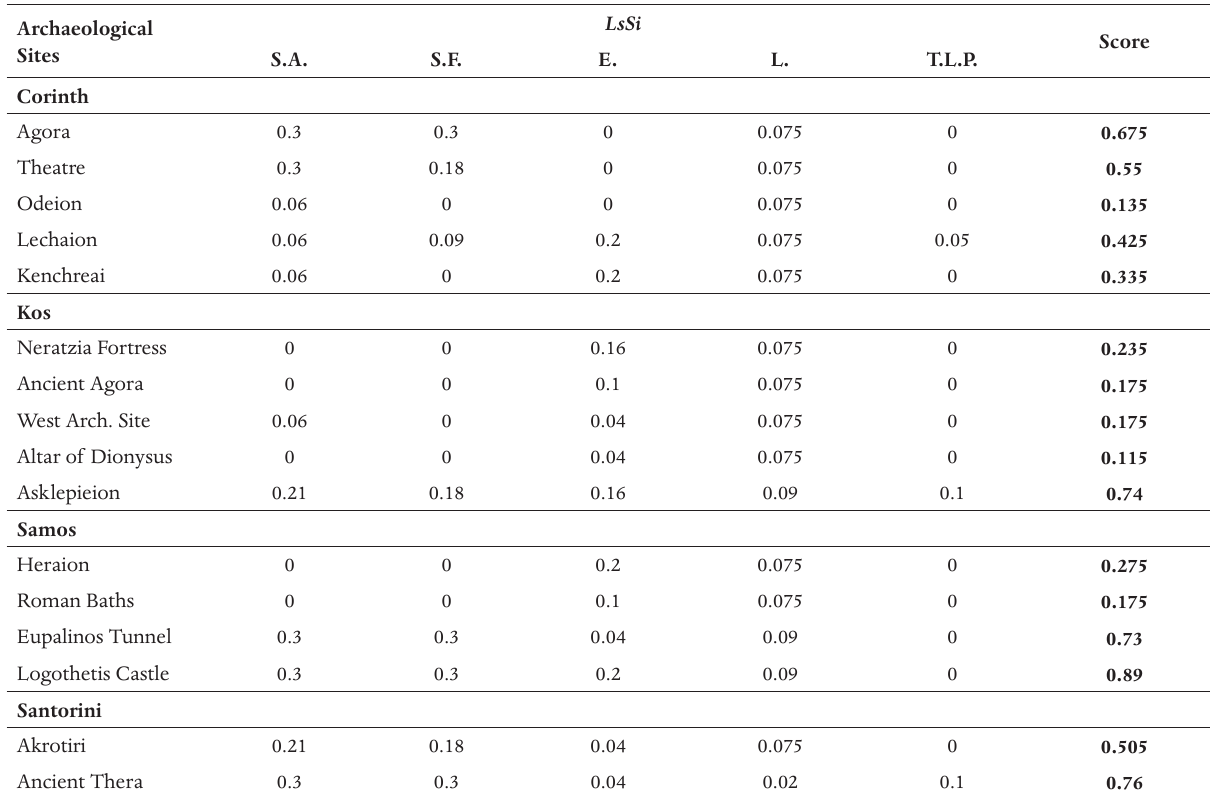
Table 2. Landslide Susceptibility indicator weighted factors and scores for the archaeological sites under study.